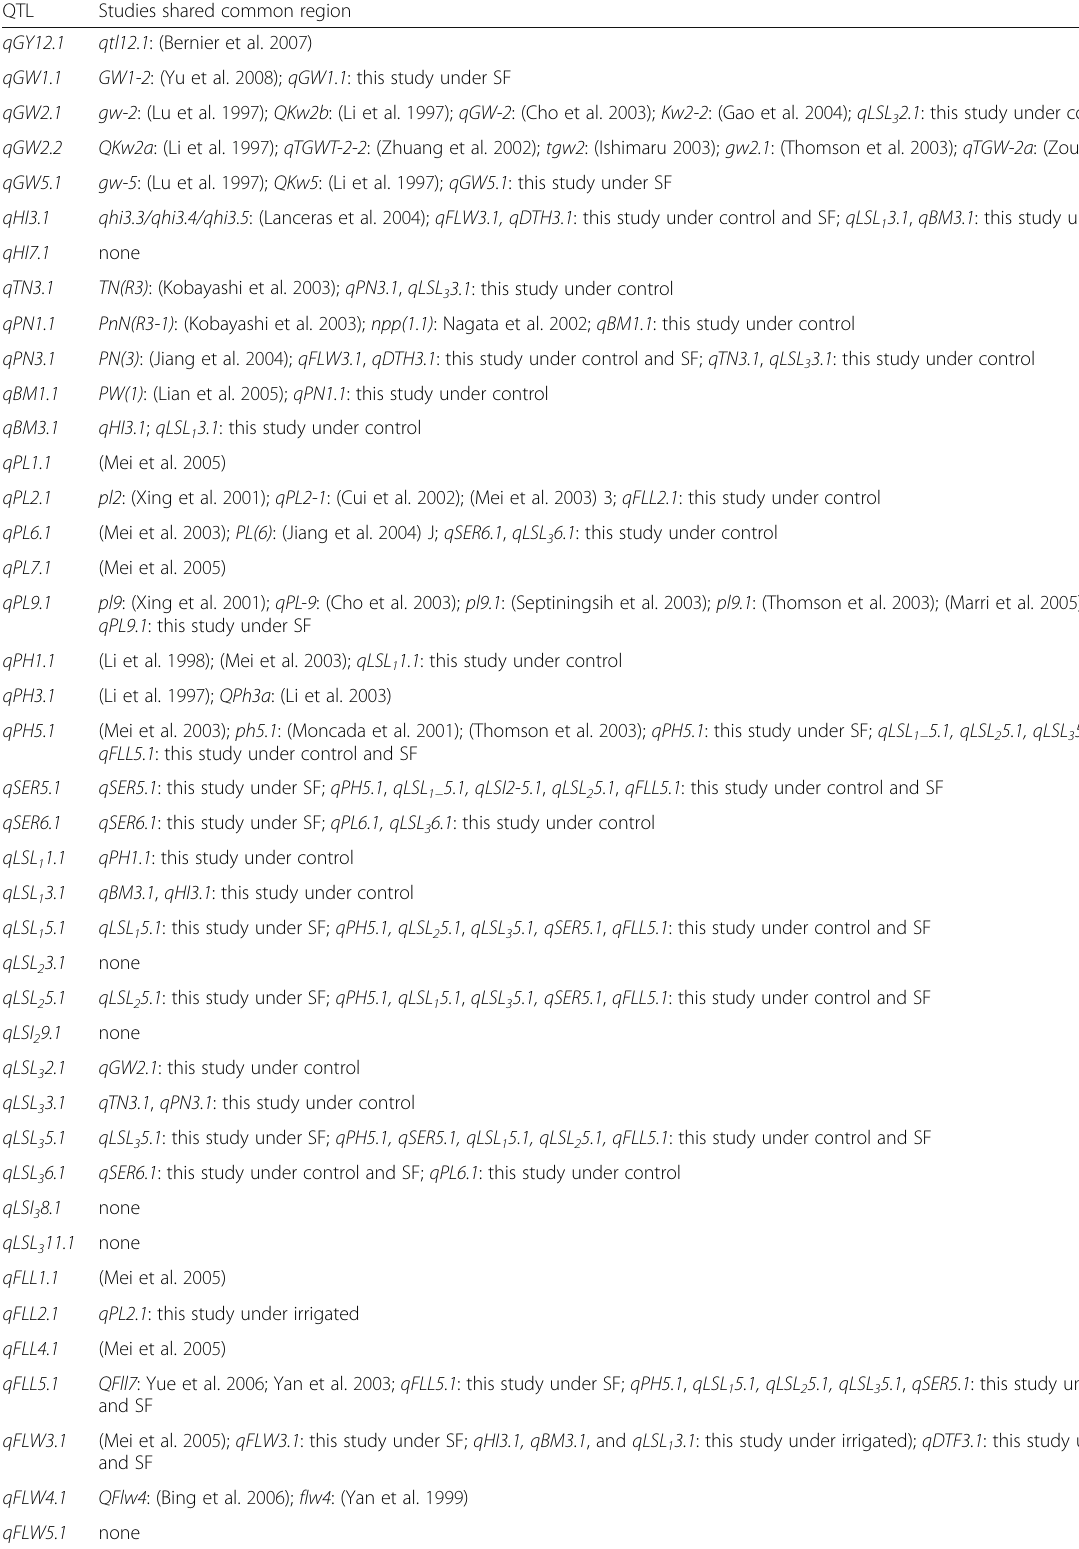
Table 6 Genomic positions of QTLs identified in control irrigated condition with its QTL cluster and comparison to the QTLs identified in stagnant flooding in this study and previously published